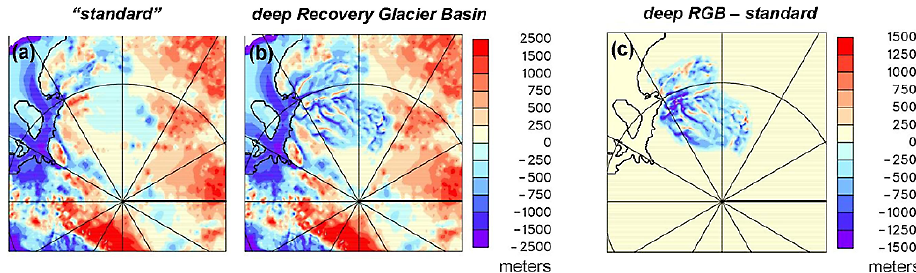
Fig. G1. (a) Modern bed elevations, meters (ALBMAP, Le Brocq et al., 2010), averaged here to 10-km model cells. (b) As (a) , except with deeper topography in the Recovery Glacier basin area, meters (LeBrocq et al., 2008, 2010). (c) Difference of (b) minus (a) .